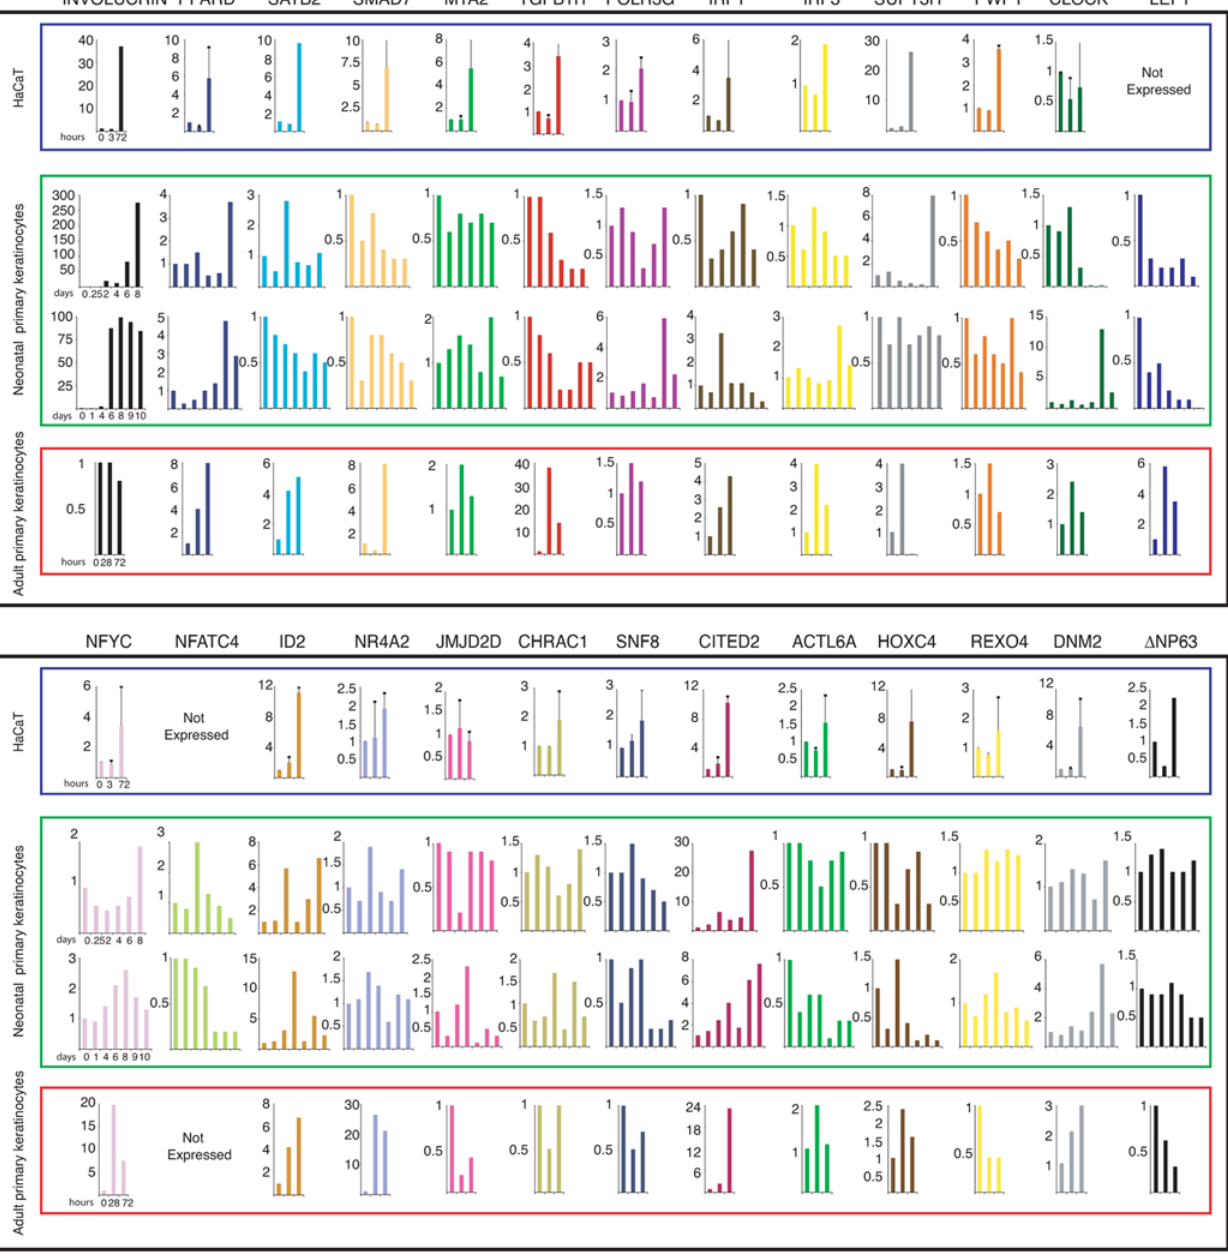
Figure 3. Expression of selected genes in differentiating HaCaT and PHK. Q-PCR analysis of the indicated genes in HaCaT (boxed in blue, mean and SD of two different experiments), neonatal (boxed in green) and adult (boxed in red) human primary keratinocytes after CaCl 2 differentiation. Time points of RNA collection are indicated on the bottom of the first chart in each row. Bars represent expression fold changes respect to the 0 time point. Please, note the different scale on the y axes of each chart. Data were normalized for GAPDH expression and INVOLUCRIN was chosen to monitor the differentiation status.